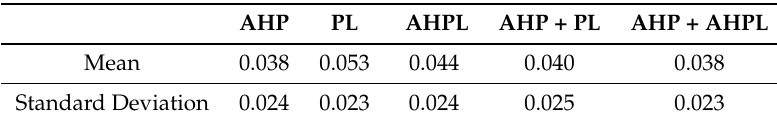
Figure 15. Robot position estimation errors for the approach trajectory. Table 2. Robot position error mean and standard deviation for the different heterogeneous landmark parametrizations in the approach trajectory in the simulated environment.